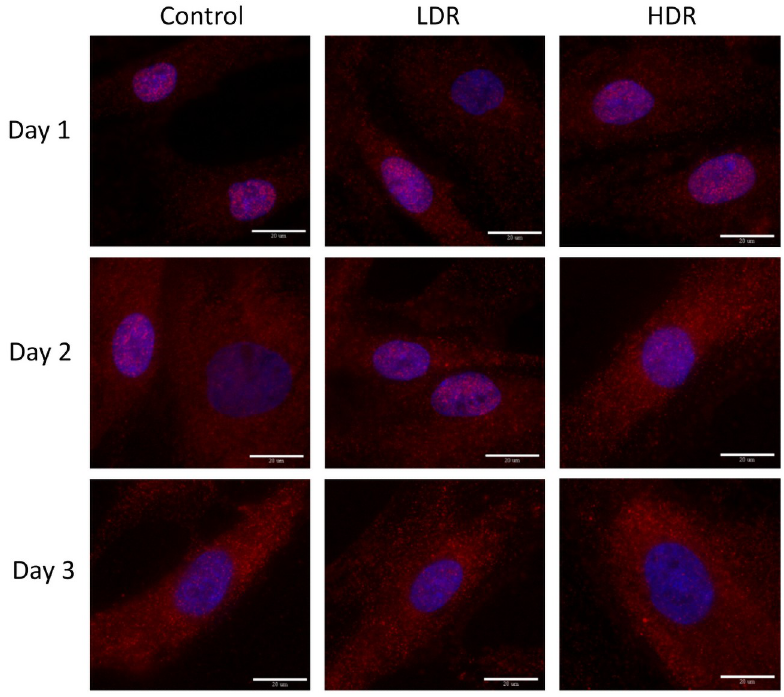
Fig 7. Representative images of p21 expression (red) in gamma irradiated hADSCs, counterstained with DAPI (blue). Images taken at 100x magnification. Bar = 20 μ m.